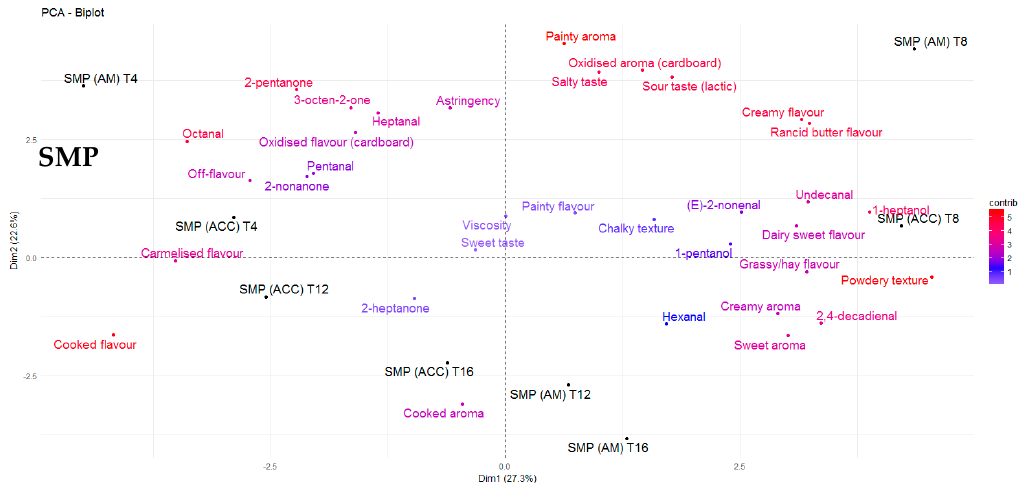
Figure 4. PCA biplot demonstrating the correlations between the sensory perception and volatile compounds for skim milk powder (SMP) at T4, T8, T12, and T16 of storage. AM: ambient, 21 °C; ACC: accelerated, 37 °C.